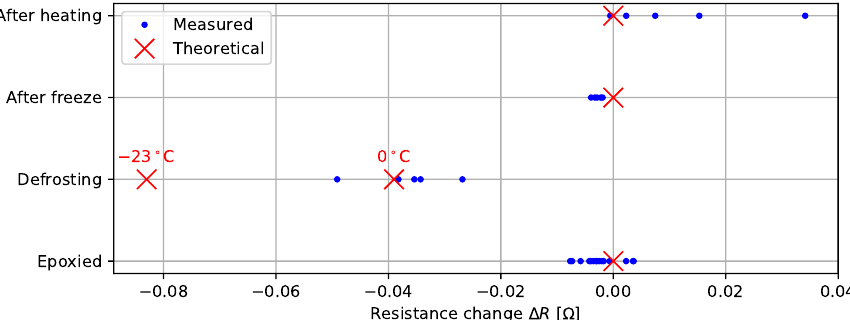
Figure 10. Trace resistance under freezing, heating, and epoxying.